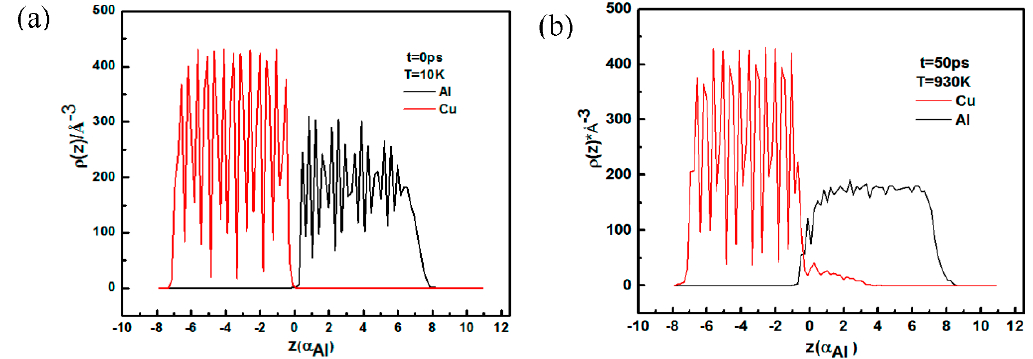
Figure 2. Concentration distribution of Cu and Al atoms at different temperatures ( a ) 10 K; ( b ) 930 K.